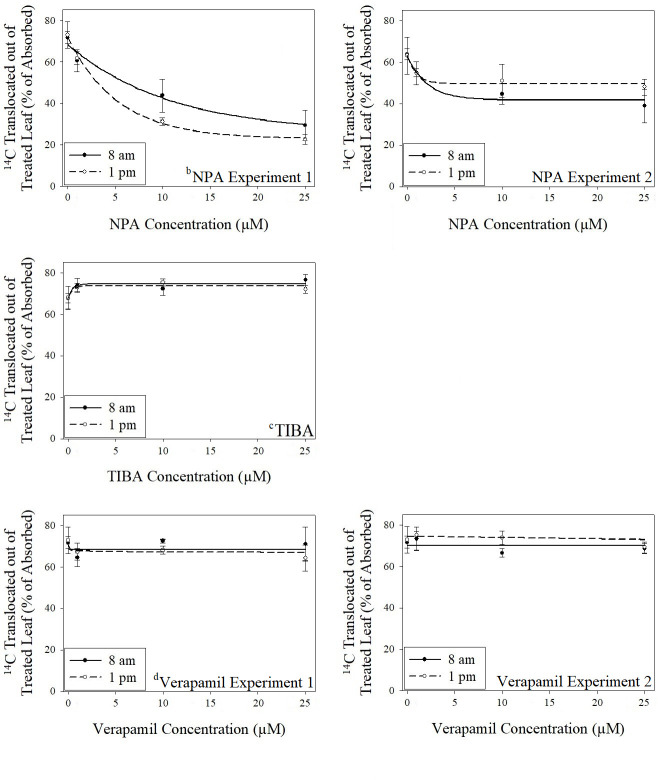
Effect of increasing translocation inhibitor concentrations on translocation of 14C-dicamba from treated leaves.aVertical bars represent standard error of the mean. bNPA = N-1-naphthylphthalamic acid. cTIBA = 2,3,5-triiodobenzoic acid. dVerapamil = 5-[N-(3,4-dimethoxyphenylethyl)methylamino]-2-(3,4-dimethoxyphenyl)-2-isopropylvaleronitrile hydrochloride. eNPA with 8 am 14C-dicamba application, experiment 1: Standard error of regression (SER) = 12.27; NPA with 1 pm 14C-dicamba application, experiment 1: SER = 7.43; NPA with 8 am 14C-dicamba application, experiment 2: SER = 9.91; NPA with 1 pm 14C-dicamba application, experiment 2: SER = 13.30; TIBA with 8 am 14C-dicamba application: SER = 8.20; TIBA with 1 pm 14C-dicamba application: SER = 8.81; Verapamil with 8 am 14C-dicamba application, experiment 1: SER = 13.32; Verapamil with 1 pm 14C-dicamba application, experiment 1: SER = 10.14; Verapamil with 8 am 14C-dicamba application, experiment 2: SER = 7.40; Verapamil with 1 pm 14C-dicamba application, experiment 2: SER = 7.54.